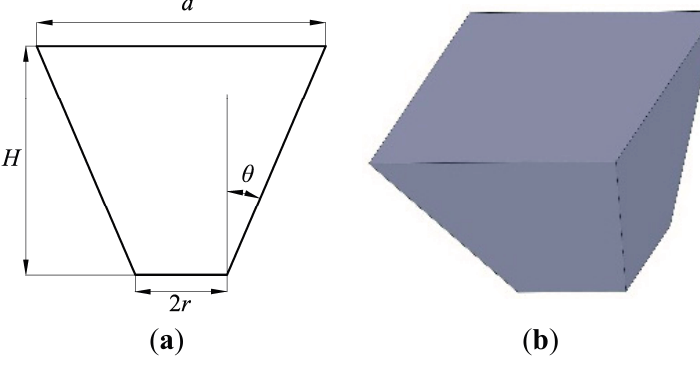
Figure 5. ( a ) Design parameters; ( b ) solid model of KFTS-type SOE.